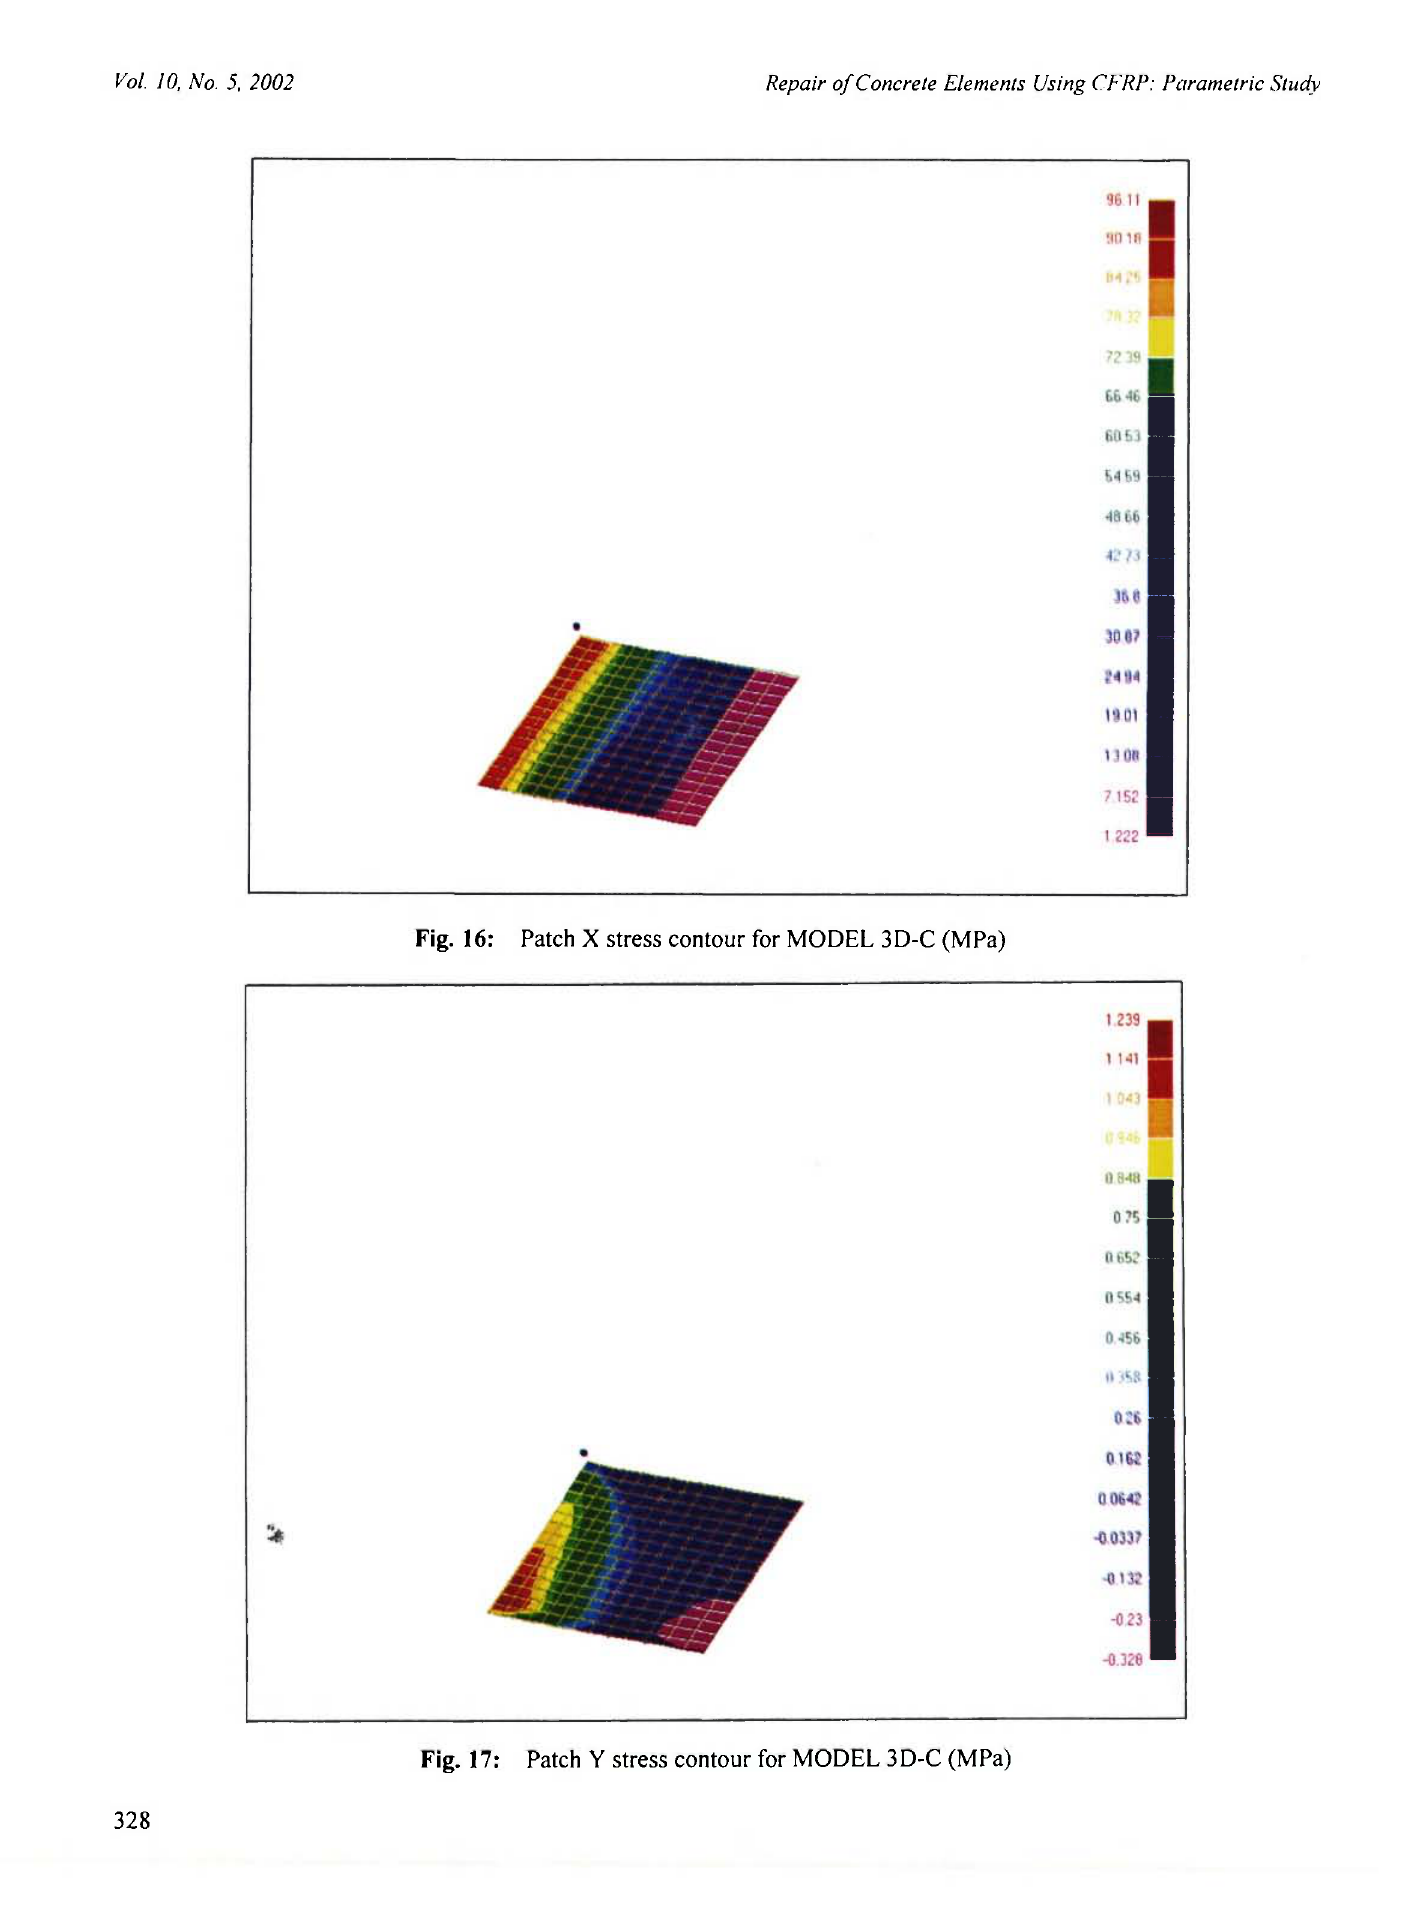
Fig. 17: Patch Y stress contour for MODEL 3D-C